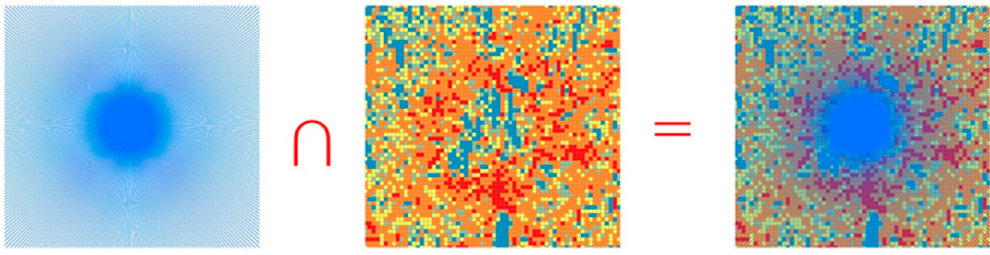
Figure 3. Schematic diagram of the data columns derived in 360 directions. (The center of the circle is blurred because the 360 lines are too dense.)